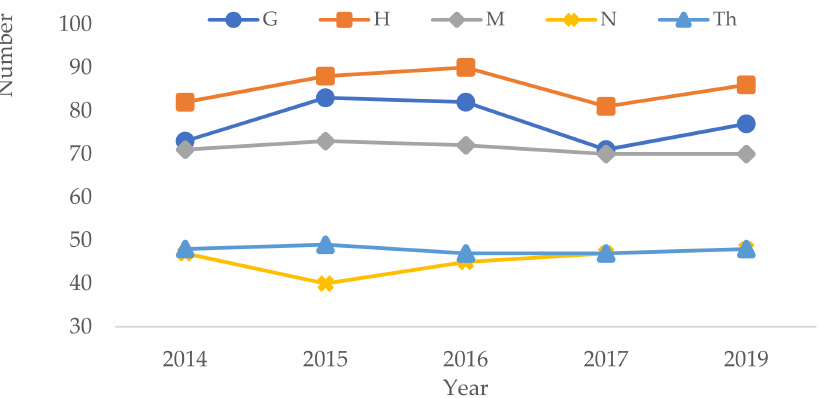
Figure 3. The plant species numbers according to Raunkiær’s life-form